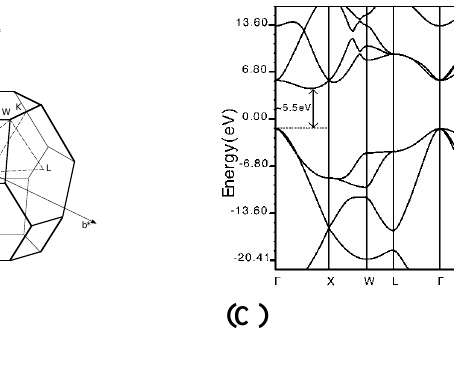
Figure S2 ( A) The calculated model of diamond; (B) The calculated B.Z; (C)